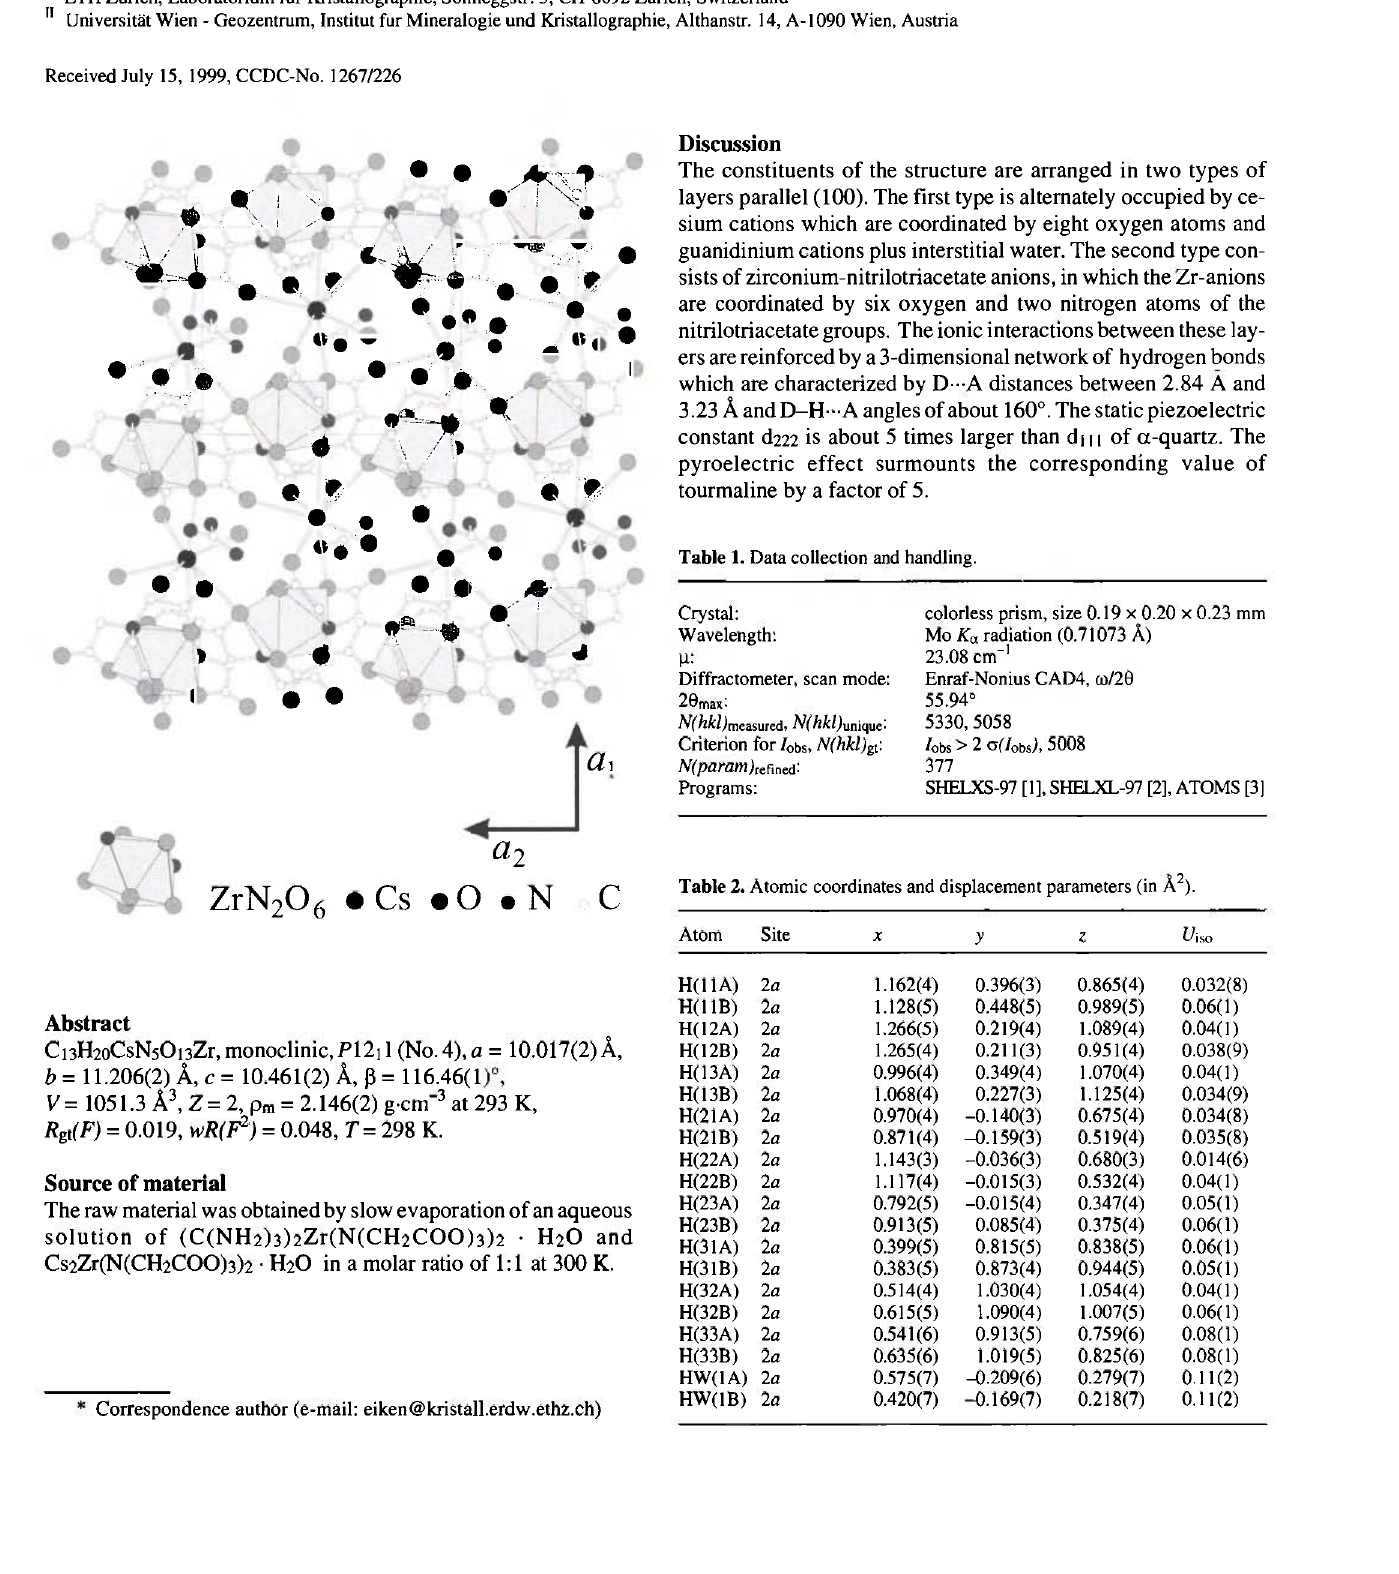
Table 2. Atomic coordinates and displacement parameters (in Ä 2